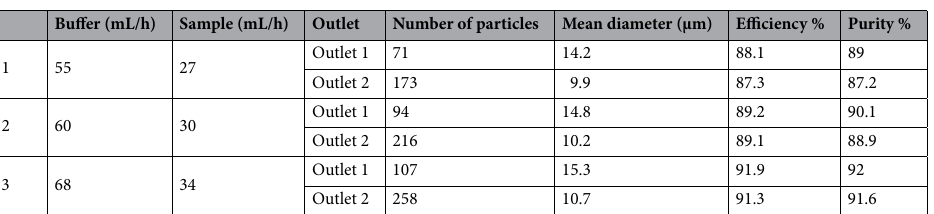
Table 5. Experimental test results for cell samples at optimum flow